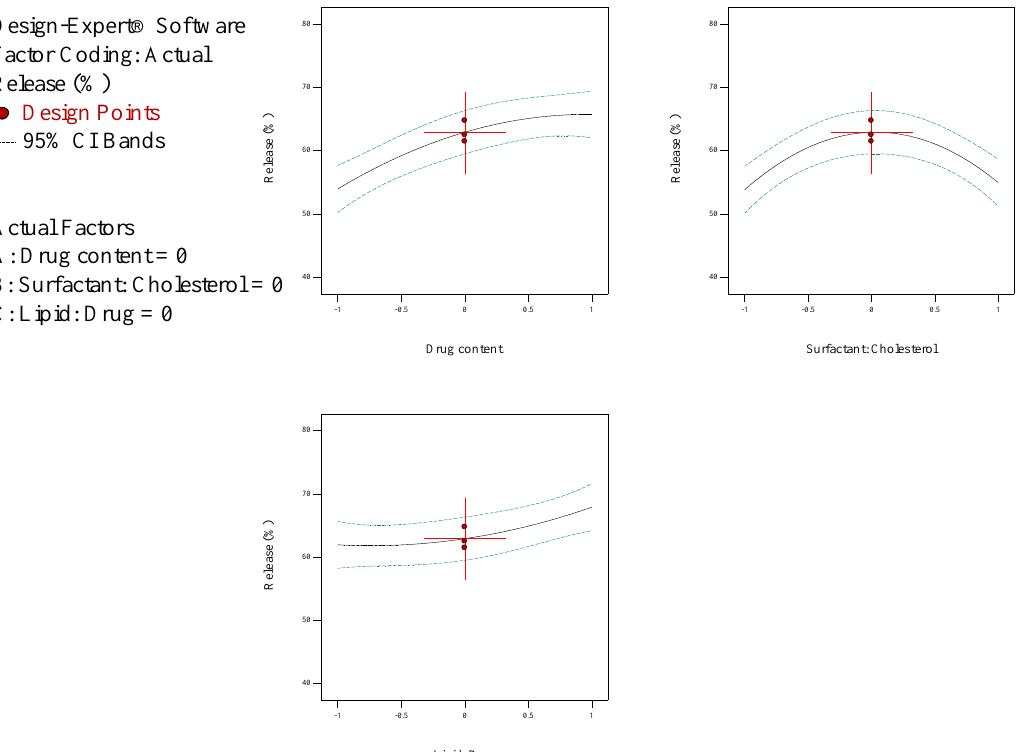
Figure 2. Box–Behnken method for release as a function of the drug content, the molar ratio of surfactant: cholesterol, and molar ratio of lipid: drug .